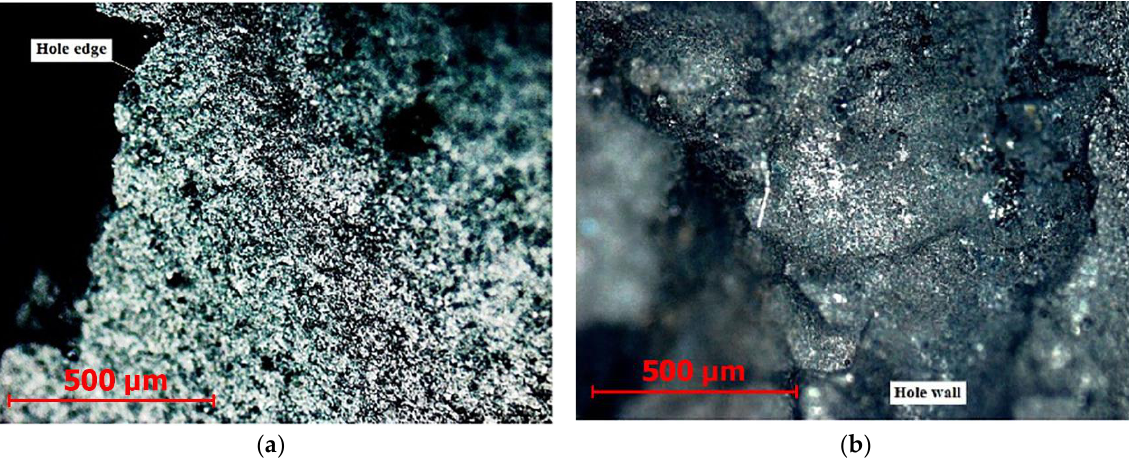
Figure 27. Photos of the hole surface when die-sinking a ceramic sample on an EDM machine: ( a ) — the edges of the hole with chips; ( b ) — hole walls with cracks. Rough, uneven edges of the hole with chips are visible, and the walls of the hole with cracks are shown. The picture gives the impression that the separation of the mate- rial was not in small portions but in large chips.